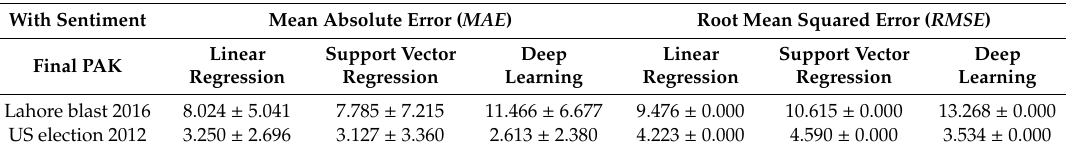
Table 7. Results for Pakistan with event sentiments.